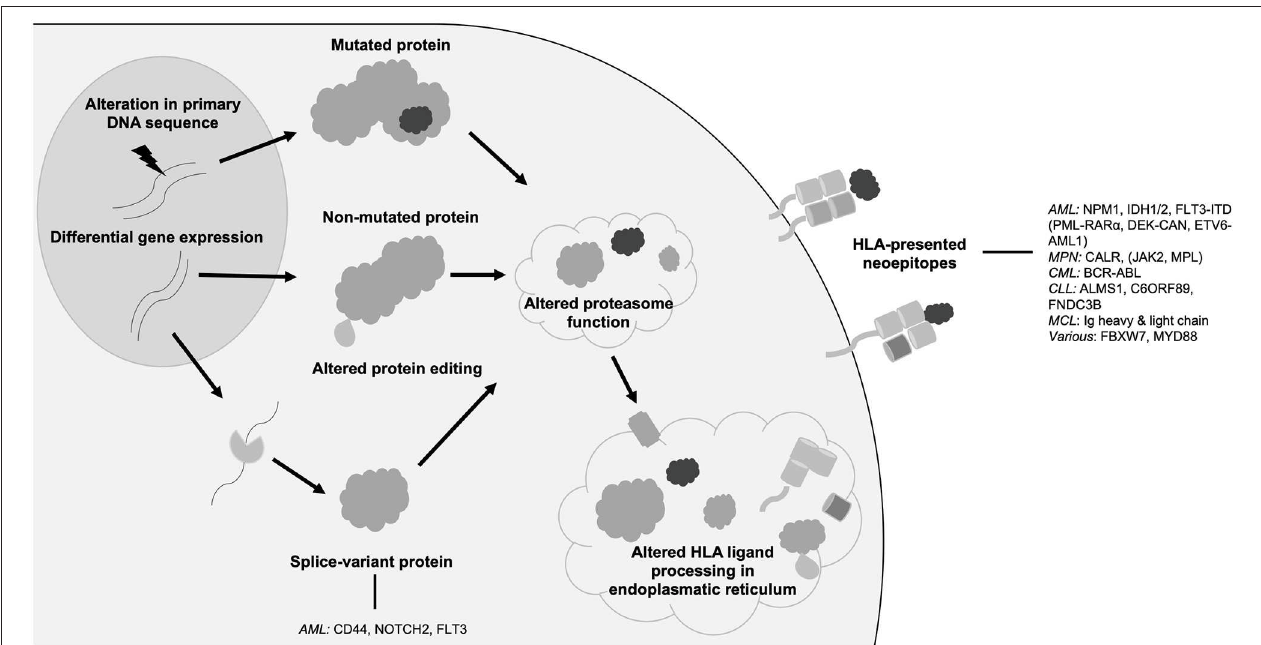
FIGURE 1 | Origins of neoantigens. Schematic overview showing different origins of neoantigens with prominent examples in hematological malignancies. AML, acute myeloid leukemia; FLT3, FMS like tyrosine kinase 3; HLA, human leukocyte antigen; NPM1, nucleophosmin 1; IDH, isocitrate dehydrogenase; MPN, myeloproliferative neoplasia; CALR, calreticulin; JAK2 janus like kinase 2; CML, chronic myeloid leukemia; CLL, chronic lymphocytic leukemia; MCL, mantle cell lymphoma; Ig,